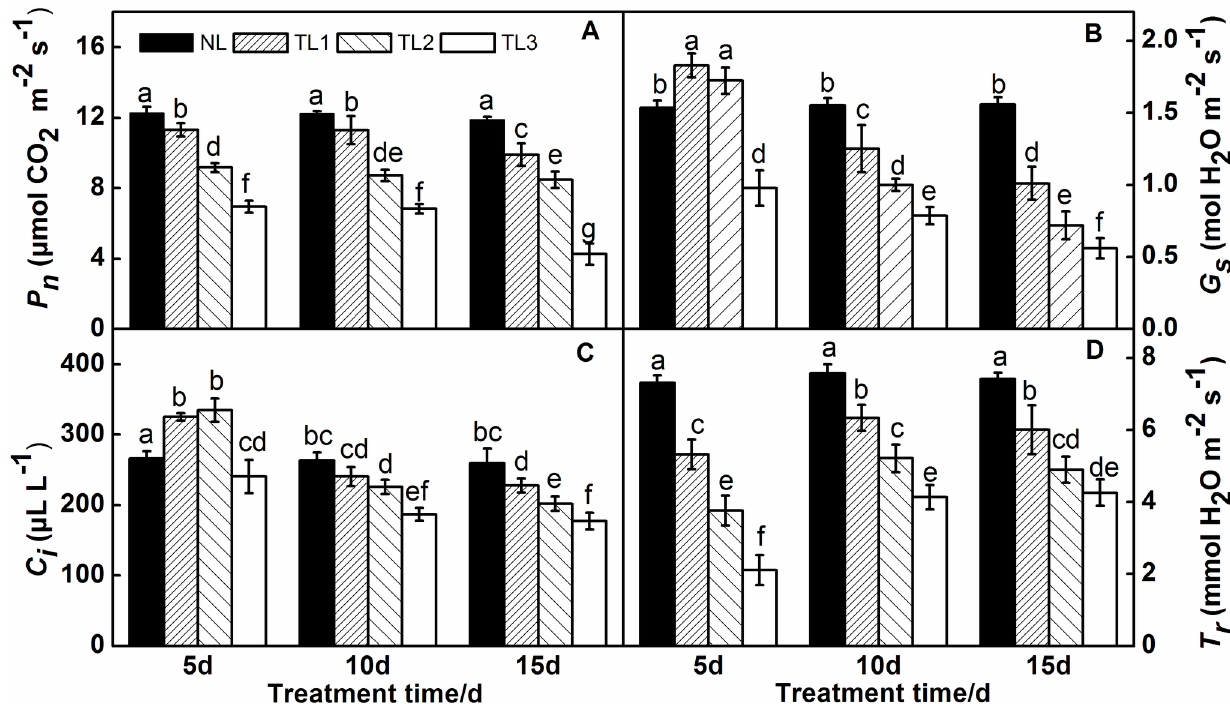
Fig 3. Effects of low light treatment on photosynthetic rate (P n ) (A), stomatal conductance ( G s ) (B), intercellularCO 2 concentration ( C i ) (C), and transpiration rate ( T r ) (D) of purplepak-choiseedlings. The data are the mean of three replicates, with SDs shownas vertical bars . The means marked with different letters indicatesignificantdifferences betweentreatments at p < 0.05,as determinedwith Duncan’smultiplerange test. Different lower-caseletters at each time point indicate significantdifferences betweentreatments.